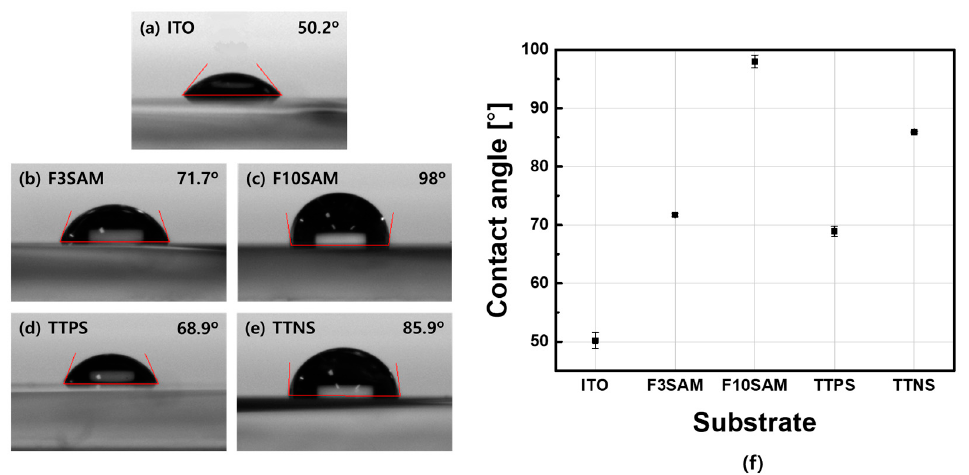
Figure 3. Contact angle measurements of SAMs on ITO: ( a ) ITO, ( b ) TTPS, ( c ) TTNS, ( d ) F3SAM, ( e ) F10SAM, ( f ) contact angle graph.